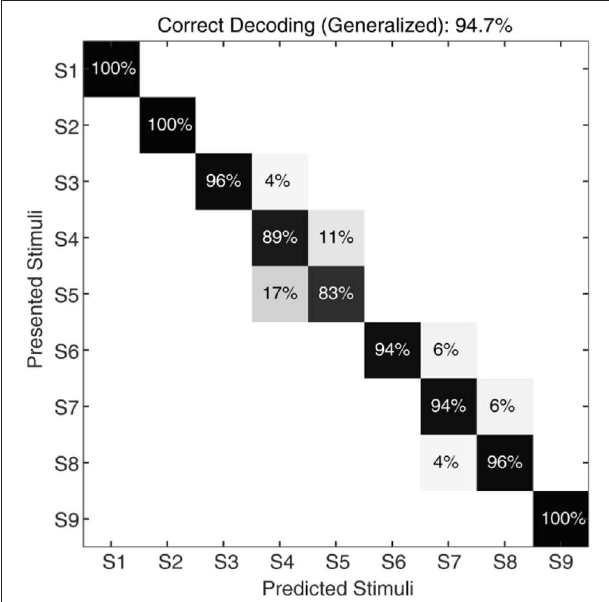
FIGURE 8 | Classification of CNs responses with noise, irrespective of sensing forces and for a given sensing velocity (5 mm/s). The confusion matrix illustrating the generalized decoding performance achieved by CNs irrespective of sensing force, across all the 9 stimuli. The decoding accuracy was 100% across 5 stimuli with a step size of 10 ◦ (S1, S3, S5, S7, and S9), and 94.7% with a step size of 5 ◦ .